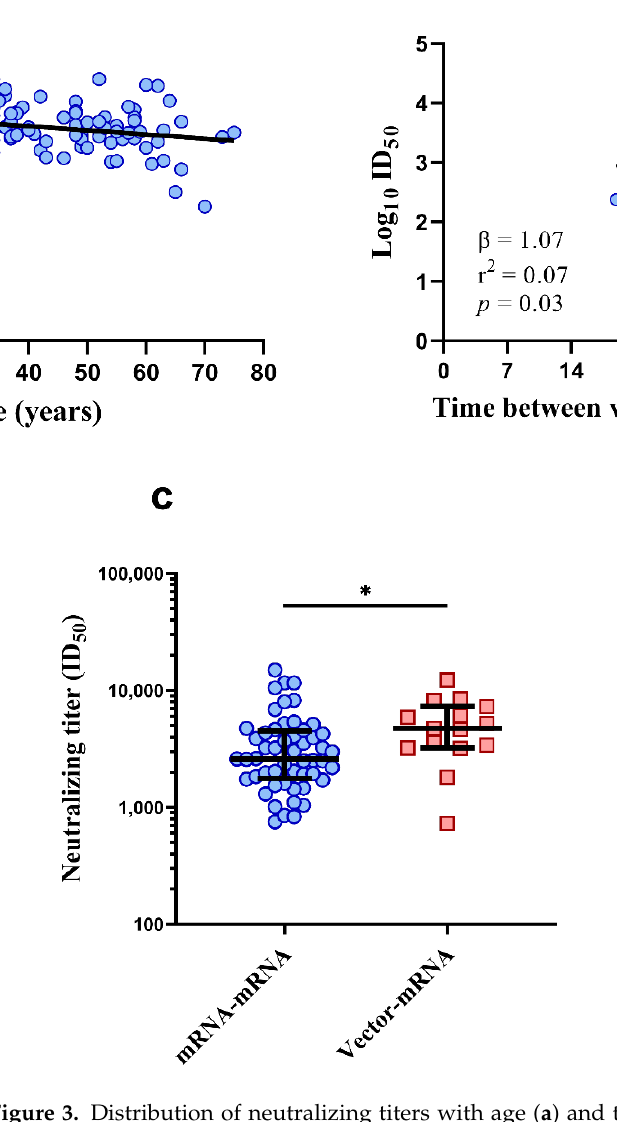
Figure 3. Distribution of neutralizing titers with age ( a ) and time between vaccination doses ( b ) in the mRNA–mRNA group ( n = 96). Comparison of age-matched neutralizing titers between the mRNA–mRNA ( n = 52, blue circles) and vector–mRNA ( n = 15, red squares) groups ( c ). Despite age- matching, neutralization titers remained significantly higher in the vector–mRNA group (* p = 0.020, Mann–Whitney U test). For ( a , b ), the bold lines represent the linear regression. For ( c ), the bold lines represent the median and interquartile range.